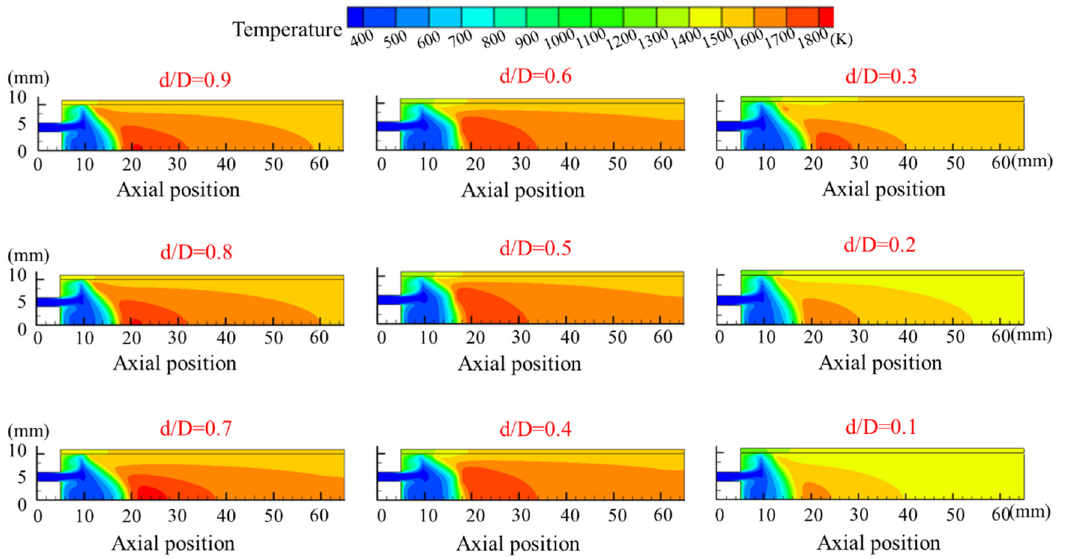
Figure 8. The temperature of different d/D porous media in combustor. Figure 9 shows the wall temperature distribution of the combustor with different porous media outer diameter ratio d/D. On the whole, the outer wall temperature of different micro combustors is similar, and they all maintain a trend of increasing first and then remaining stable. However, careful analysis shows that the outer wall temperature is not linear with d/D, and there is an optimal value. When d/D increases from 0.1 to 0.5, the outer wall temperature increases as a whole, and the trend is the same, but as d/D continues to increase to 0.9, the outer wall temperature no longer increases but decreases. It can be seen that when d/D is 0.5, that is, when the thickness of the large-pore and small-pore layer is the same, the heat transfer capacity is the best.